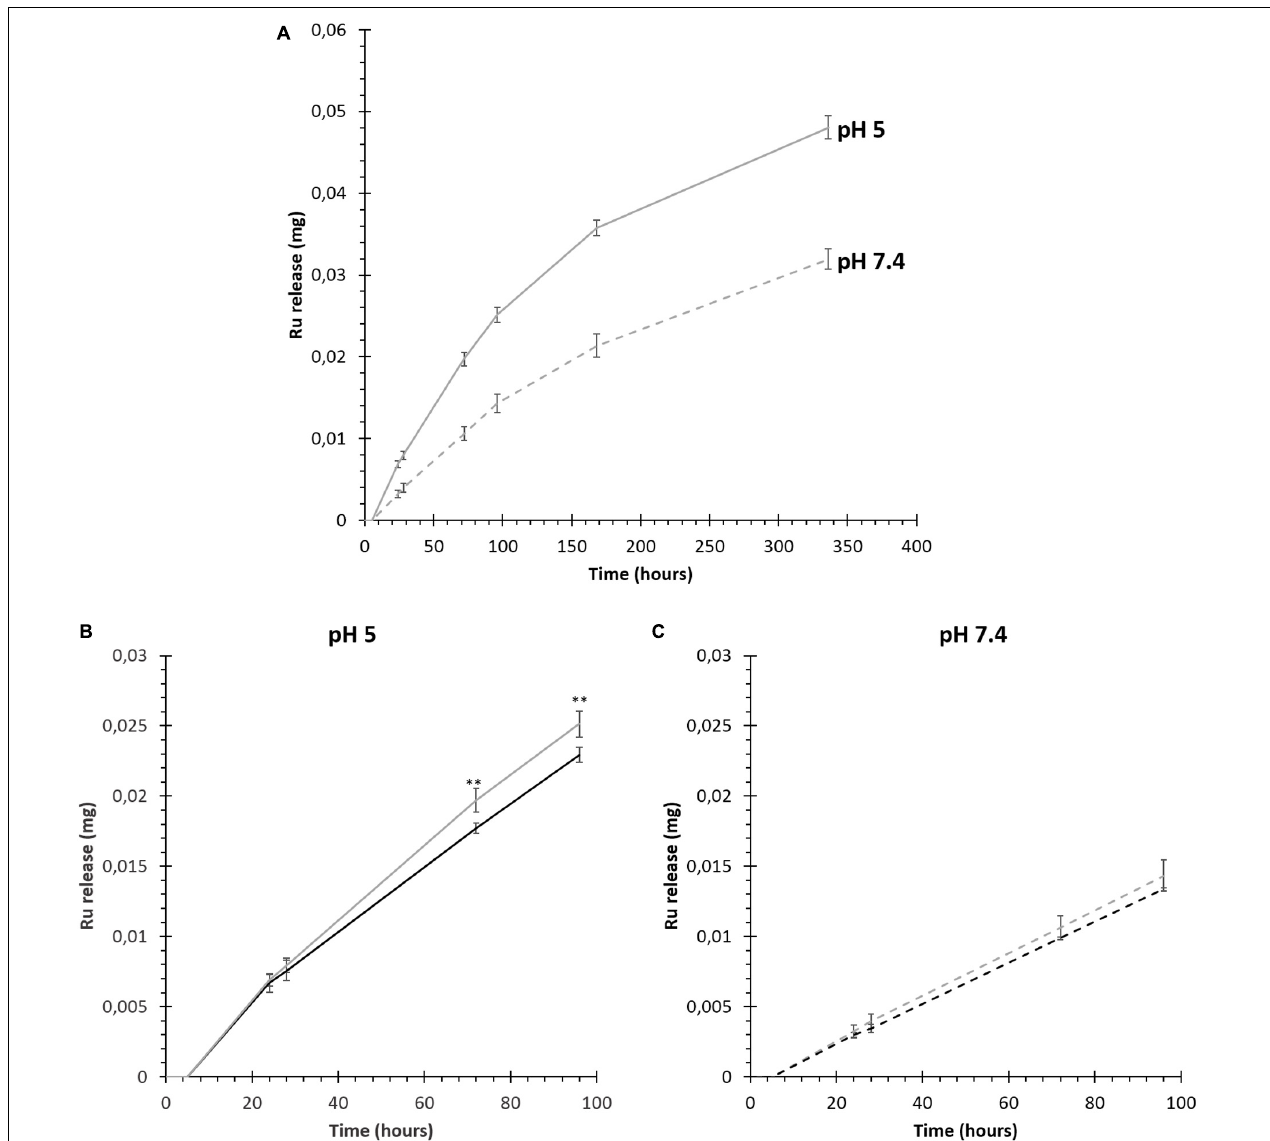
FIGURE 6 | Release of Ru dye from MSN-CS-SIP-Ru-containing hydrogels (NHP407_MSN-CS-SIP-Ru in black, SHP407_MSN-CS-SIP-Ru in gray) in aqueous media at pH 5 and pH 7.4. (A) Ru release from SHP407_MSN-CS-SIP-Ru hydrogels incubated in acetate buffer at pH 5 (continuous line) or in phosphate buffered saline (pH 7.4) (dashed line). (B) Trend of Ru release in pH 5 aqueous environment from NHP407_MSN-CS-SIP-Ru (black continuous line) and SHP407_MSN-CS-SIP-Ru hydrogels (gray continuous line) within the first 4 days of observation. (C) Ru release in PBS (pH 7.4) from NHP407_MSN-CS-SIP-Ru (black dashed line) and SHP407_MSN-CS-SIP-Ru hydrogels (gray dashed line) within the first 4 days of observation.